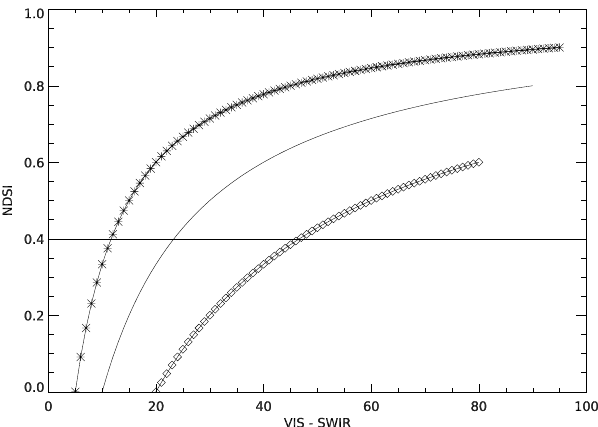
Figure 1. NDSI plots. NDSI values are plotted for three specified conditions. (1) The solid line is the NDSI with the VIS reflectance increasing from 0 to 100% in increments of 1% while the SWIR re- flectance is constant at 10%. (2) The line with asterisks shows VIS reflectance increasing from 0 to 100% in increments of 1% while the SWIR reflectance is constant at 5%. (3) The line with diamonds shows VIS reflectance increasing from 0 to 100% in increments of 1% while the SWIR reflectance is constant at 20%.